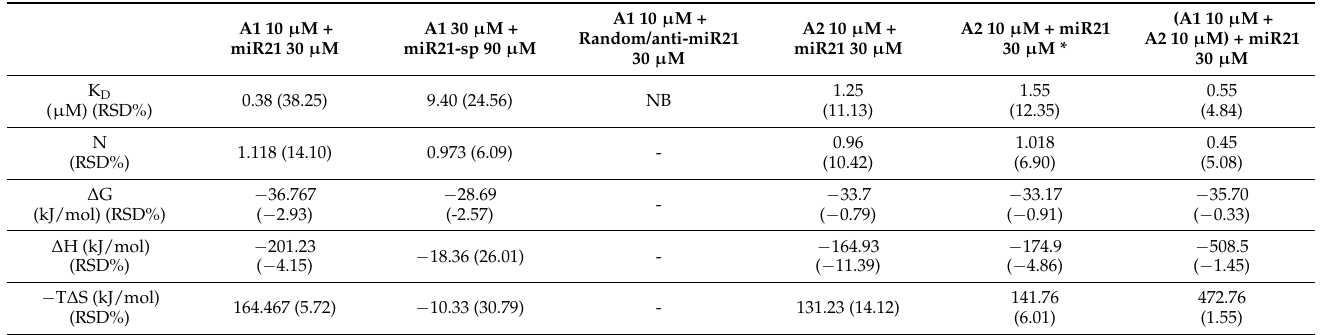
Table 2. Thermodynamic parameters for the interaction of A1 with miR21 and its analogues and for the interaction between A2 and miR21.